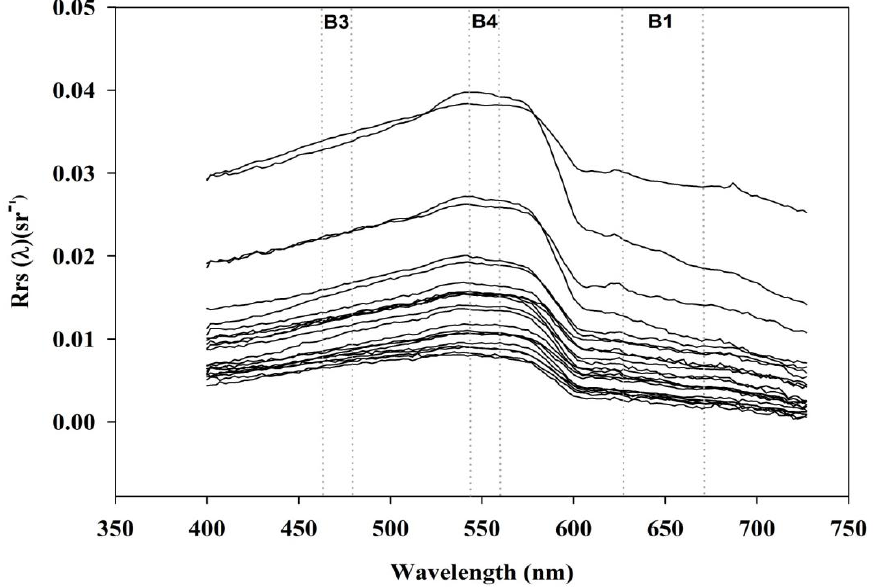
Figure 2. R with the limits of Moderate Resolution Imaging Spectroradiometer (MODIS) rs Bands 1, 3 and